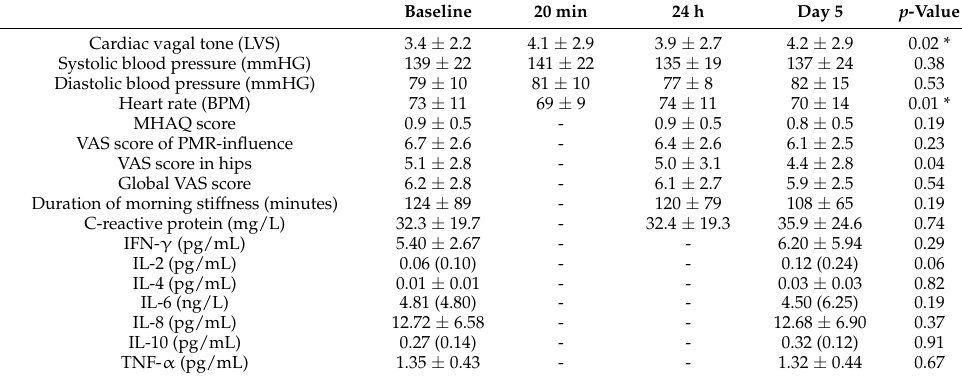
Table 2. Changes in